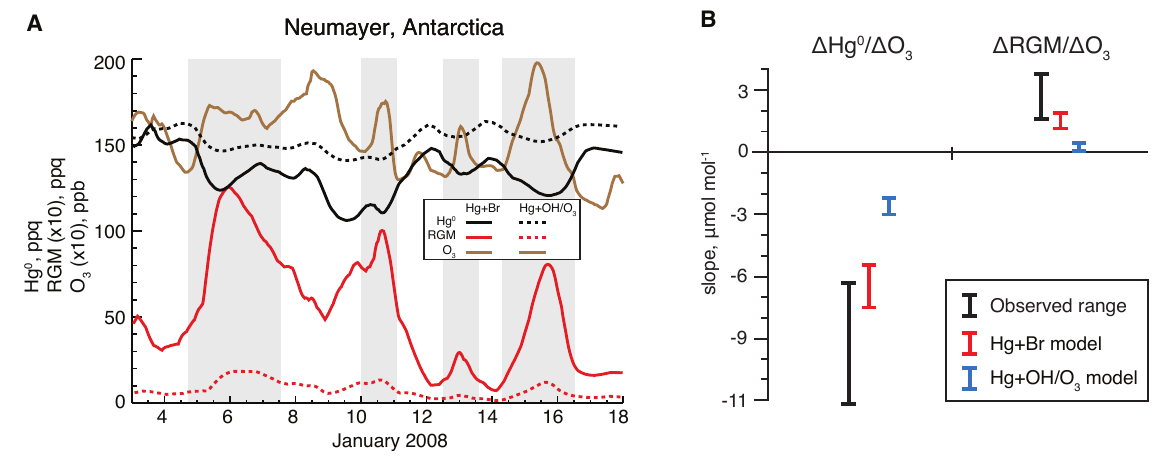
Fig. 8. (A) Time series of Hg 0 , RGM and O 3 simulated at Neumayer, Antarctica in the Hg+Br and Hg+OH/O 3 models. Shaded re- gions show summertime subsidence events diagnosed with relative humidity and O 3 data. (B) 1 Hg 0 /1 O 3 and 1 RGM /1 O 3 ratios during January–February. Observed ratios were calculated from data reported by Temme et al. (2003). Modeled ranges are 95% confidence intervals for the reduced major-axis slope from the bootstrap method.